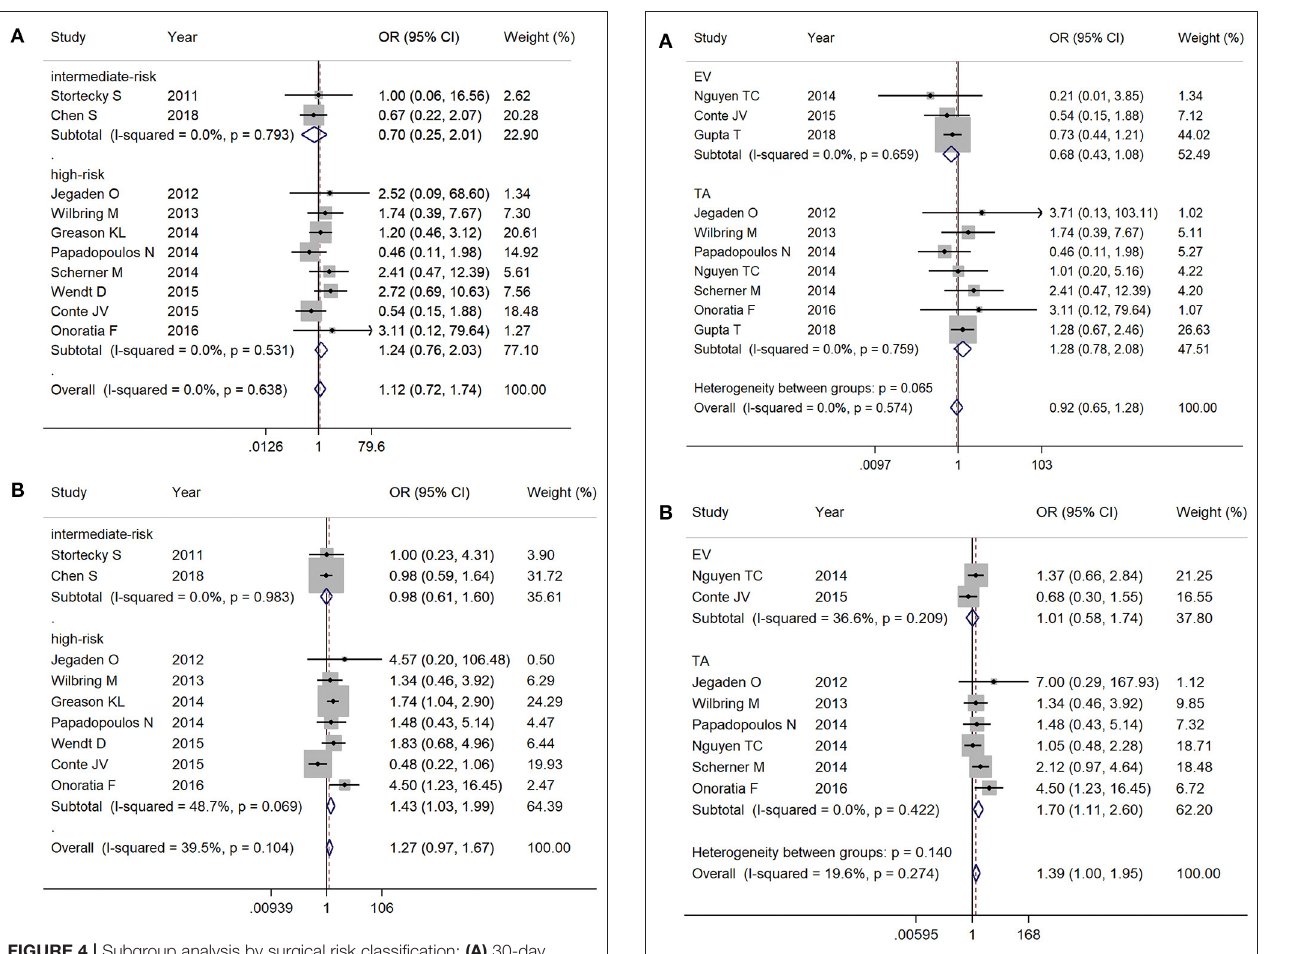
of PCS patients was ∼ 25%. Before TAVR was commercially